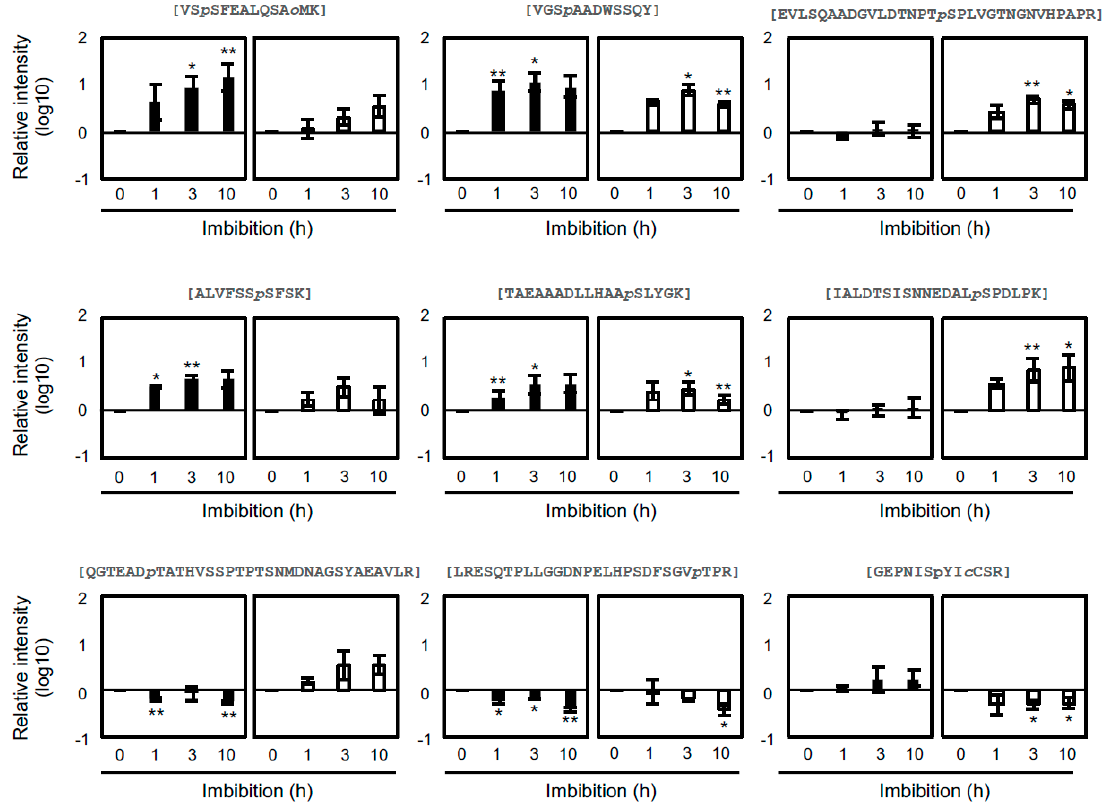
Figure 3. Examples of phosphopeptides in barley seeds. Quantitative data of each phosphopeptide was analyzed for FH (solid) and AR (empty) grains treated with imbibition. Bars indicates ± standard error ( n = 3), and * and ** indicate p -values of <0.05 and <0.01, respectively.